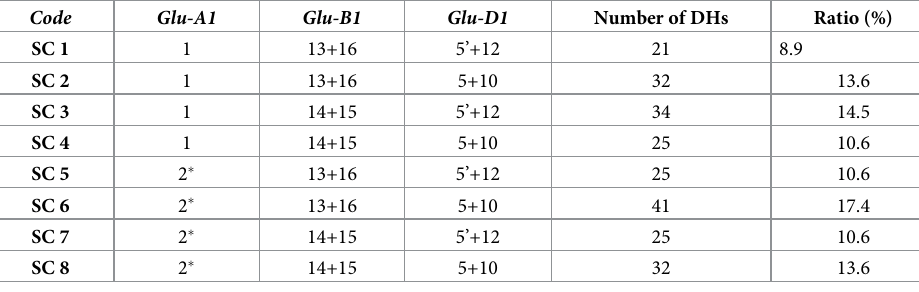
Table 1. Occurrence of HMW-GSs in the